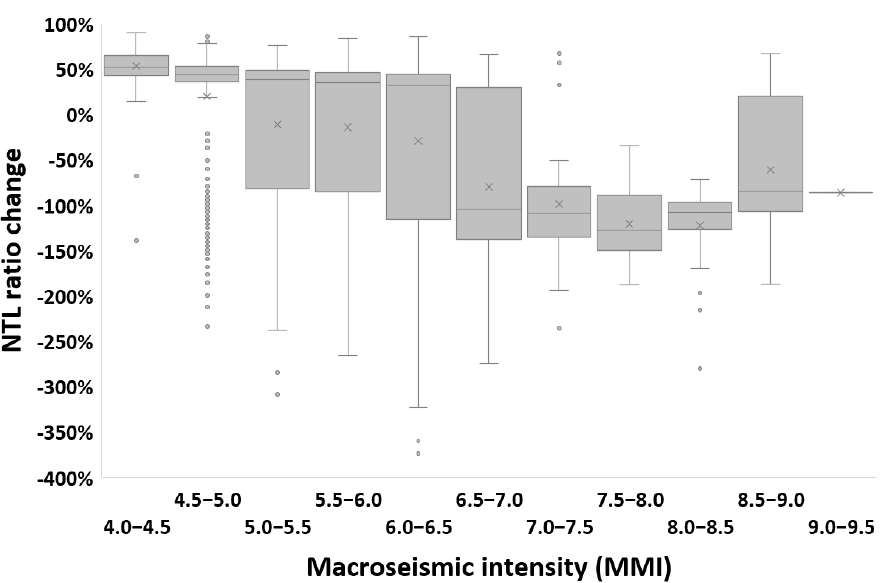
Figure 4. Statistically significant ( p < 0.01) NTL changes between the median of the period before the earthquakes (1 January–5 February, 36 days) and the median of the period after the earthquakes (7–20 February, 14 days), expressed as the ratio between the difference and pre-earthquake NTL values. NTL ratio changes > 0% indicate a decrease in NTL, whereas negative ratios indicate an increase in NTL. Boxplots of NTL ratio changes for VIIRS lit grid cells in the study area are shown as a function of MMI values based on the shakemap of the 7.5 magnitude earthquake.